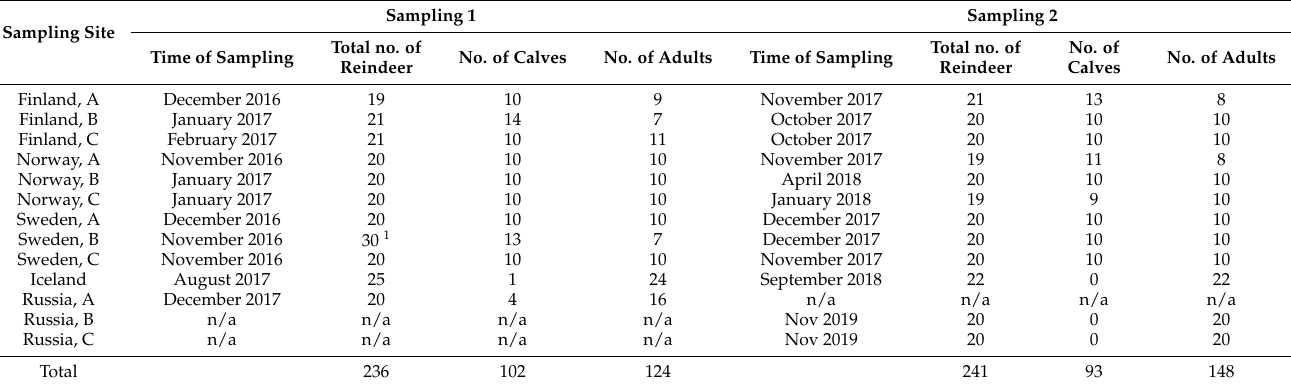
Table 3. Details of the 477 rectal swabs Eurasian tundra reindeer (Rangifer t. tarandus), including calves ( ≤ 1 year) and adult animals (>1 year), in Finland, Norway, Sweden, Iceland, and Russia. Sampling was performed during two consecutive years. Swabs were taken from three geographically separate herds in each country except for Iceland, where the wild reindeer population was sampled.